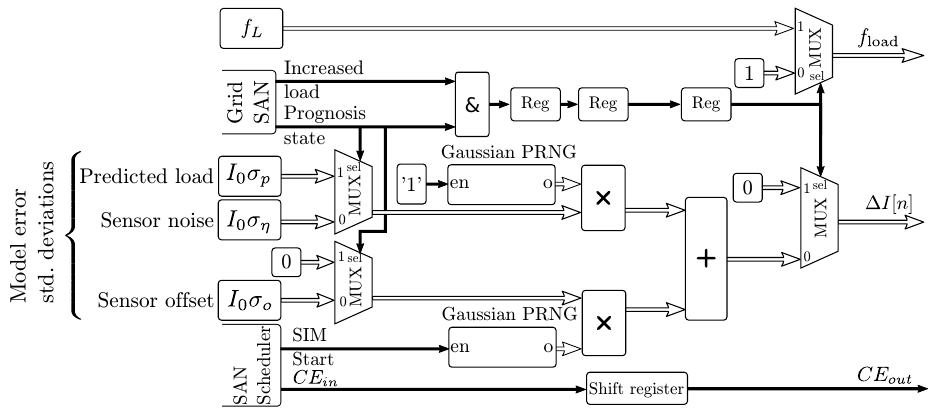
Figure 15. Pipelined load uncertainty